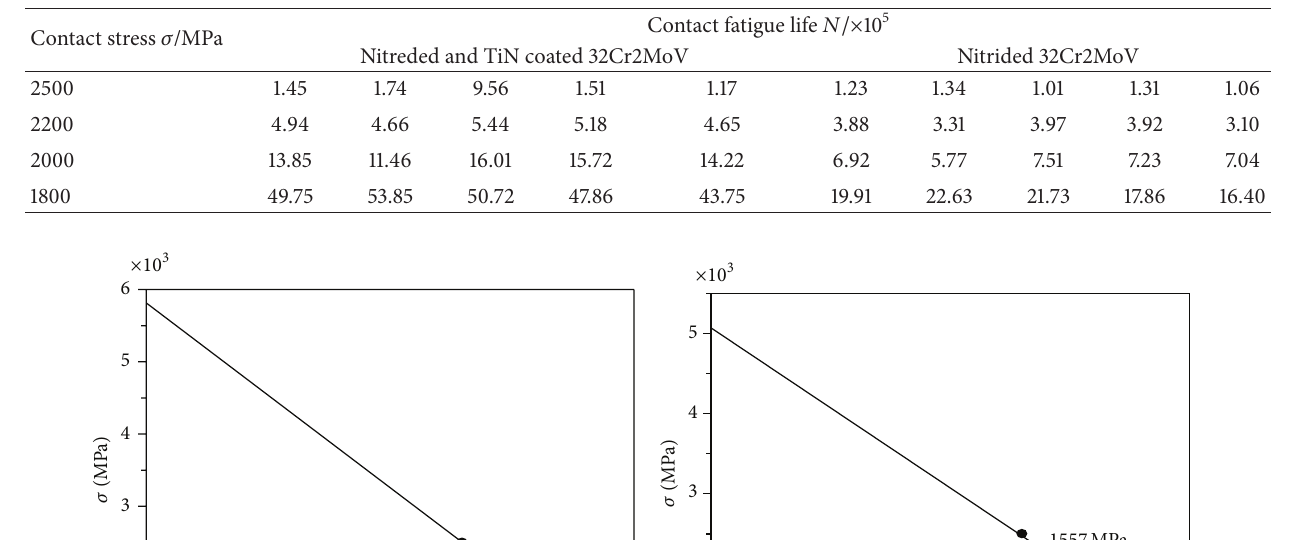
Table 4: Contact fatigue life of gears under different contact stress levels.